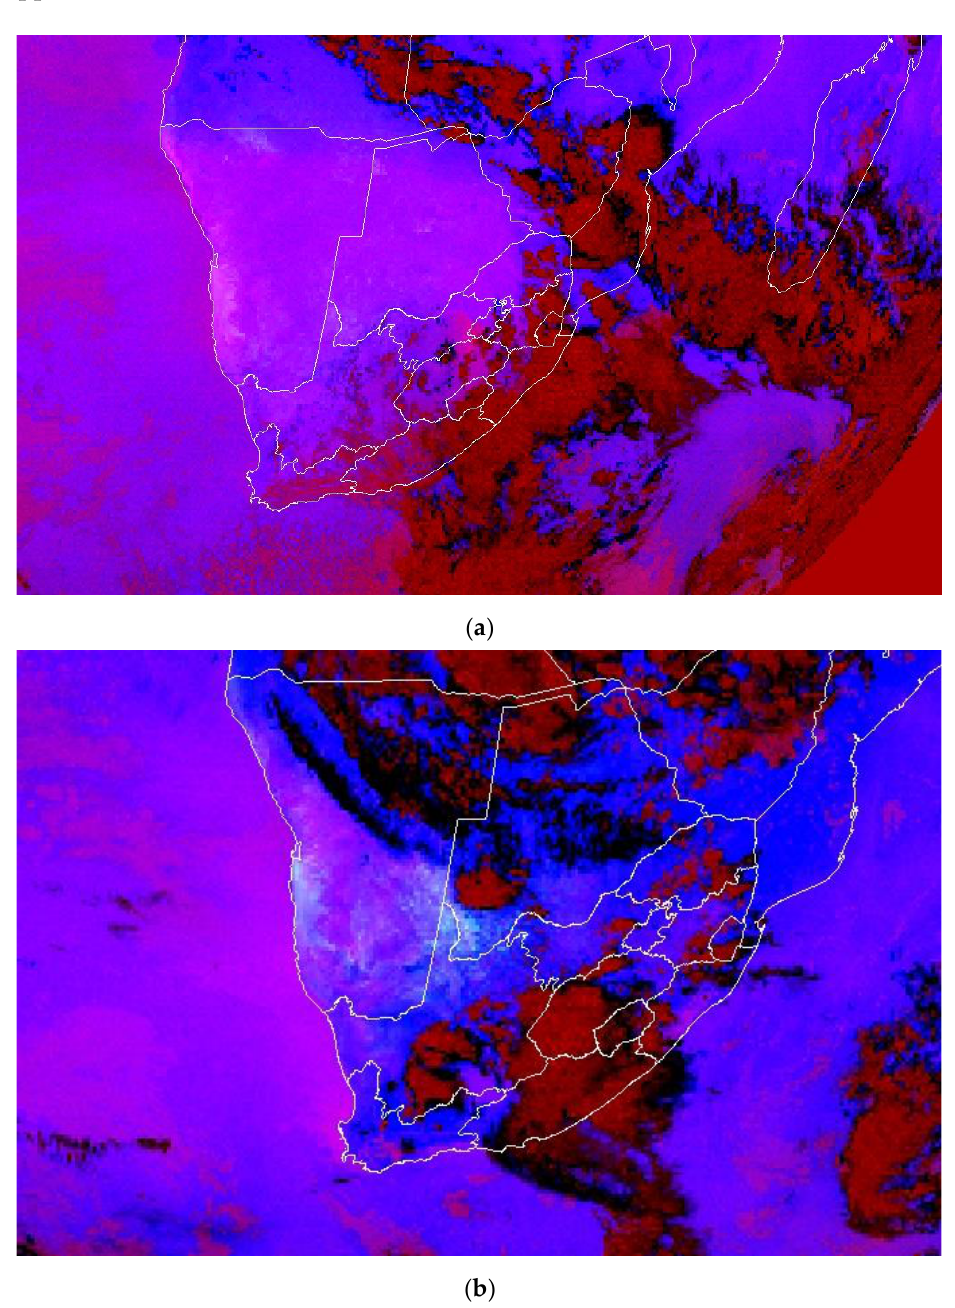
Figure A1. EUMETSAT dust RGB image for ( a ) 16 October 2014 16:00 UTC and ( b ) 13 January 2016 15:00 UTC (© EUMETSAT) using these three different colors to identify atmospheric properties: Red discriminates dust from ice and water, discriminates thick and thin clouds, and detects moisture boundaries. Green detects cloud phase, identifies optical properties, and detects dusts and moisture features. Blue detects cloud top temperatures. Dust clouds are generally at a low level and have a high contribution of blue. Therefore, the contribution of red and blue means that dust is represented by a magenta color. In the event of 2016, it is not possible to detect dust beneath the cloud.